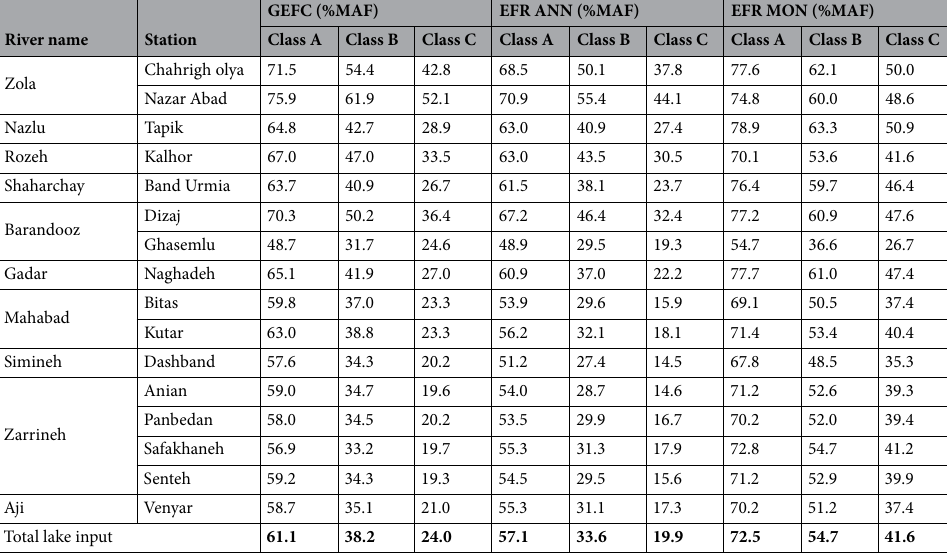
Table 1. Comparison of estimated EFR from the conventional method of GEFC with two new annual (EFR Ann) and monthly (EFR Mon) methods as the percentage of the MAF of the Urmia Lake basin rivers.